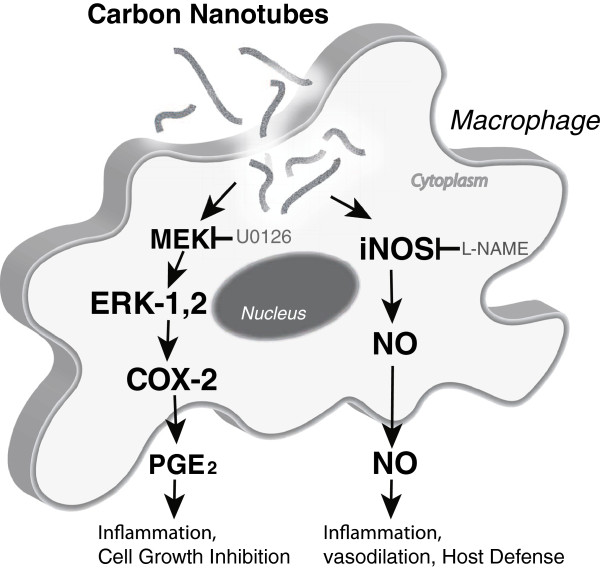
Hypothetical scheme depicting uptake and intracellular signaling induced by MWCNTs leading to induction of COX-2, iNOS, and their respective secreted metabolites in RAW264.7 cells. MWCNTs activate the MEK-ERK signaling cascade, which is required to induce COX-2 and production of PGE2. MWCNTs also induce iNOS and generation of NO through an ERK1,2-independent mechanism. The MEK inhibitor (U0126) and the iNOS inhibitor (L-NAME) are indicated along with their pharmacologic targets.